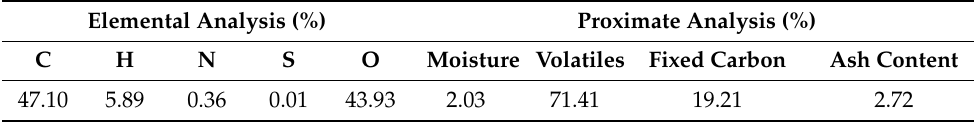
Table 1. Elemental and industrial analysis of pine